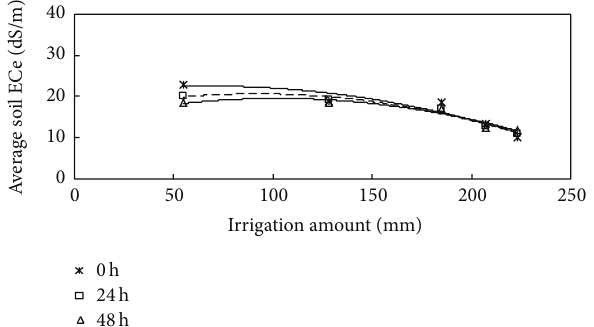
Figure 4: Relationships between average ECe in wetted zone and irrigation amount.